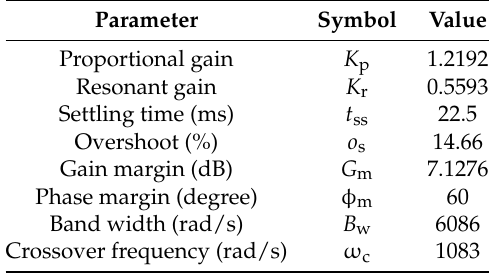
Figure 6. Solutions that comply with the tuning limits. Table 3. Selected solution of the controller